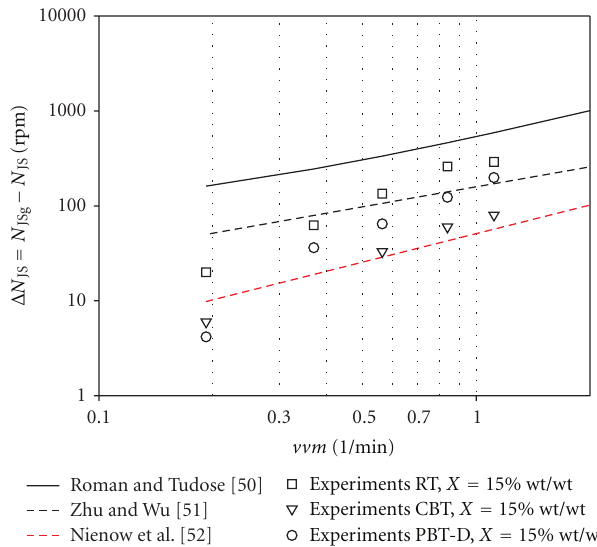
Figure 8: Variation of N JS by increasing scale and comparison with di ff erent scale-up procedures [3, 48, 49].